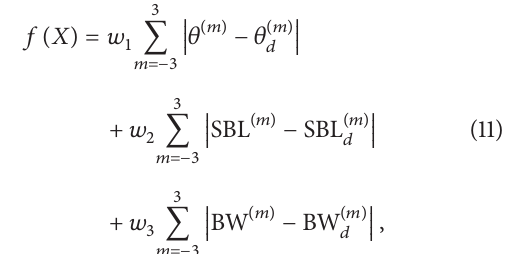
Figure 7: The multiple beams generated by subarray 1 and subarray 2 at different sidebands with different pointing